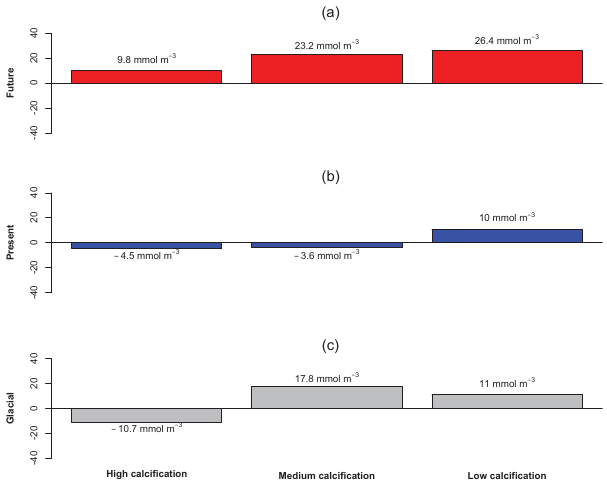
Figure 13. Bar plots depicting cumulative sum of PIC residual (model–data misfit) from day 13 to day 18 of the experiment for three replicates in mean solution of HC, MC, and LC ensembles. First row shows mesocosms with high CO 2 treatment (future), sec- ond row medium CO 2 treatment (present), and third row low CO 2 treatment